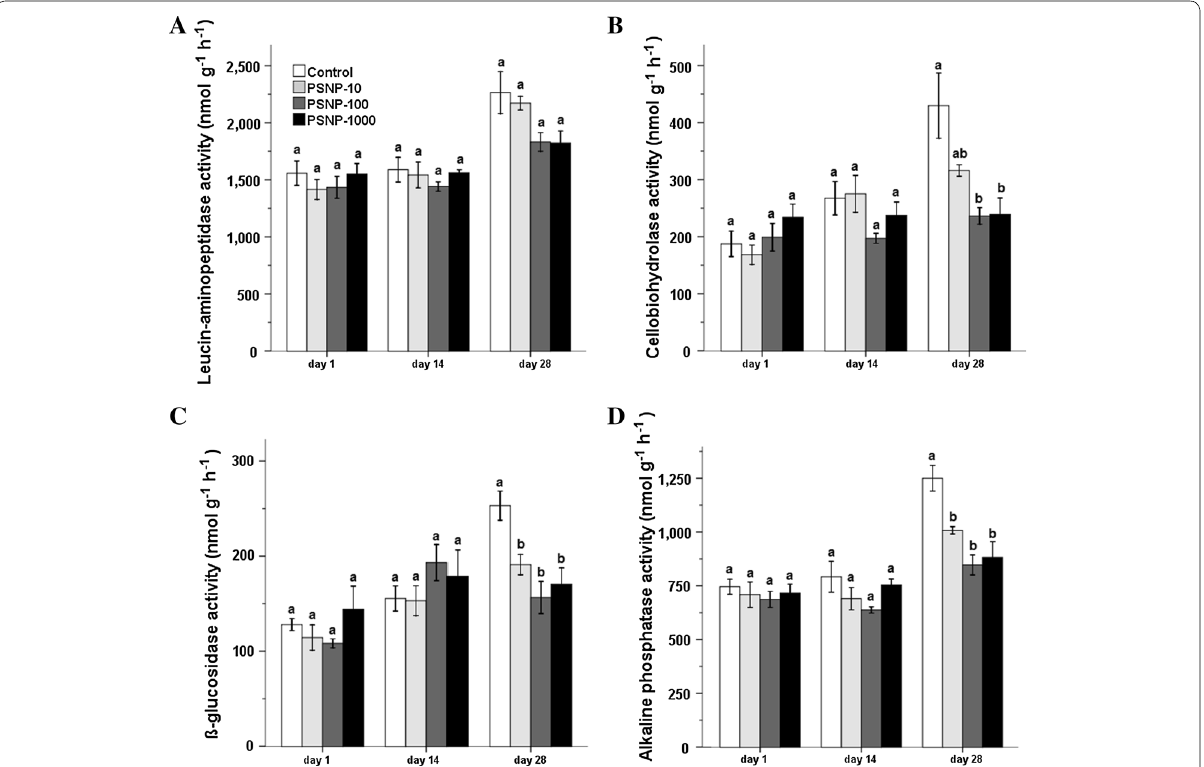
Fig. 3 Mean ( SE, n 5) of extracellular enzyme activity A leucin‑aminopeptidase, B cellobiohydrolase, C 1,4‑β‑glucosidase, and D alkaline ± = phosphatase under different PS‑NP concentrations of 10 (PSNP‑10), 100 (PSNP‑100), and 1000 (PSNP‑1000) μg kg − 1 dry soil at three time points during 28 days of incubation. Significant differences between the treatments are indicated by different letters (ANOVA and post hoc Tukey‑B test; p <